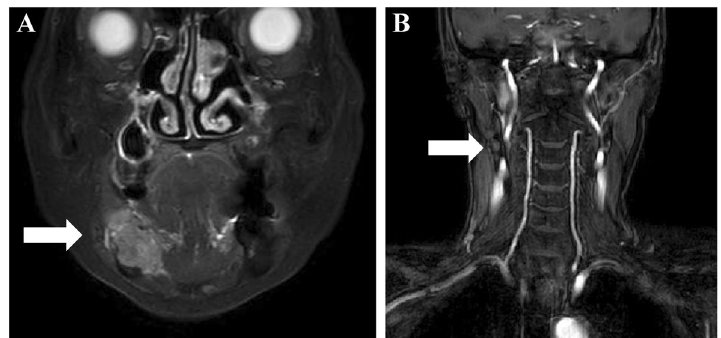
Fig. 5 Preoperative MRI images. Enhanced coronal magnetic resonance images showing a a lesion of approximately 35 a level III lymph node swelling on the right